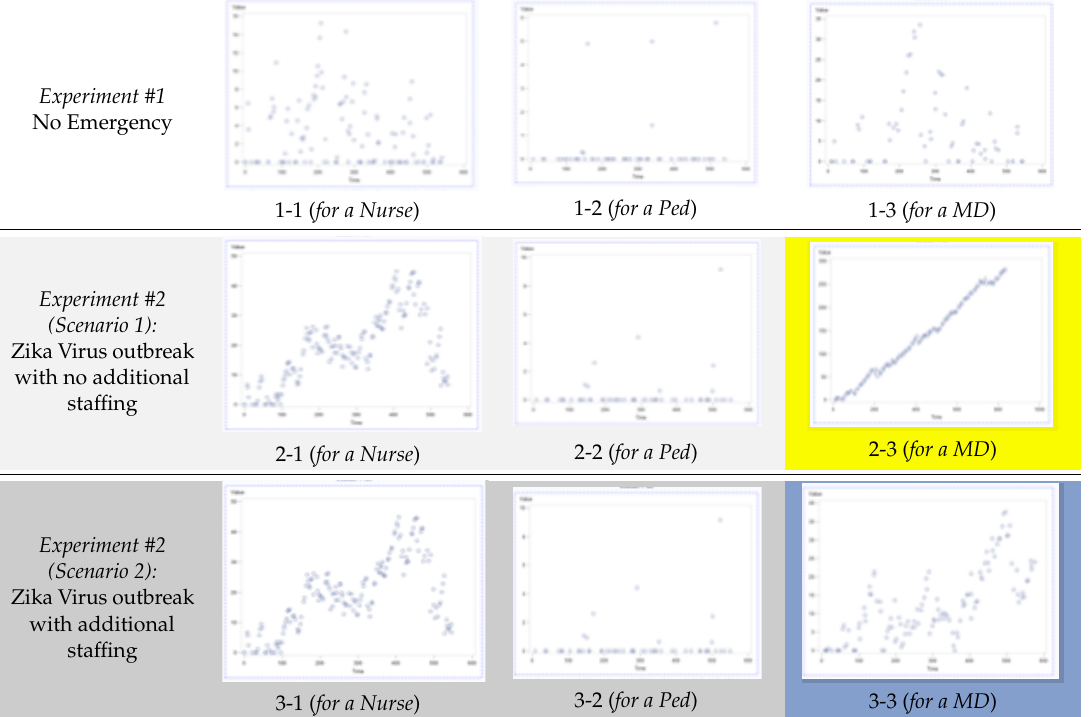
Table 5. Scatter plots of the values of average waiting time per patient vs. time for each experiment.